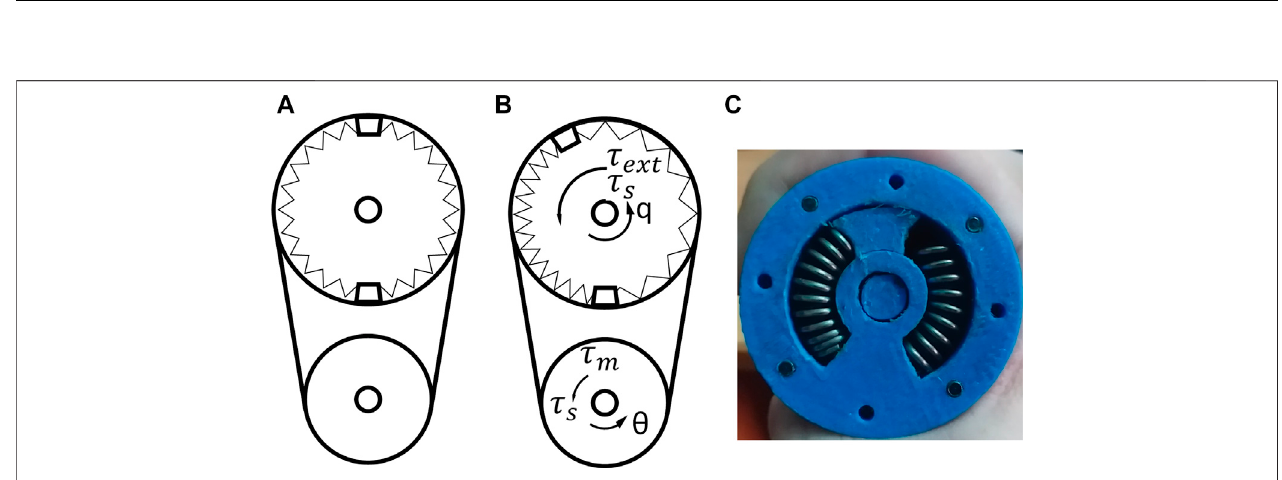
FIGURE 3 | Elastic joint system (A) without external force/torque (B) compressed/tensed by external action (C) compression of the springs on the real prototype.